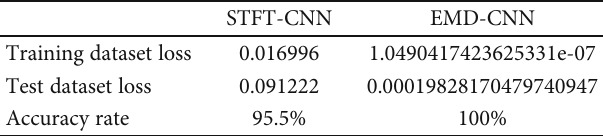
Table 2: Comparison of two